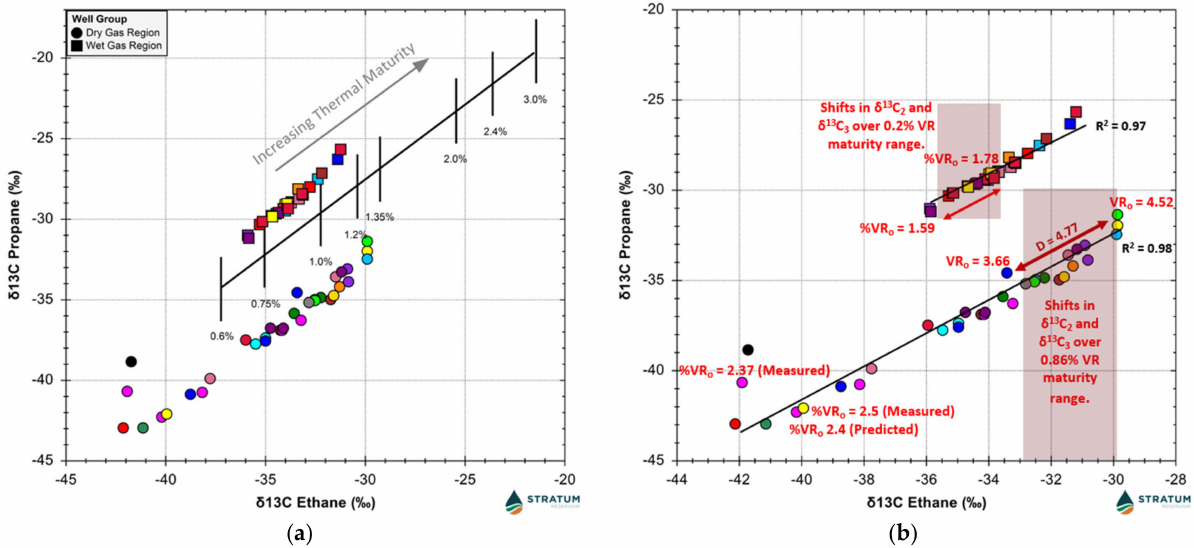
Figure 18. ( a ) Modeled vitrinite reflectance equivalents based on calculations published by Faber [66] and Whiticar [67]. ( b ) The same plot including calibration to actual VR o measurements based on the distance calculated for the relevant δ 13 C 2 – δ 13 C 3 pairs (method suggested by Jennifer Adams, Stratum Reservoir, 2019 personal communication).